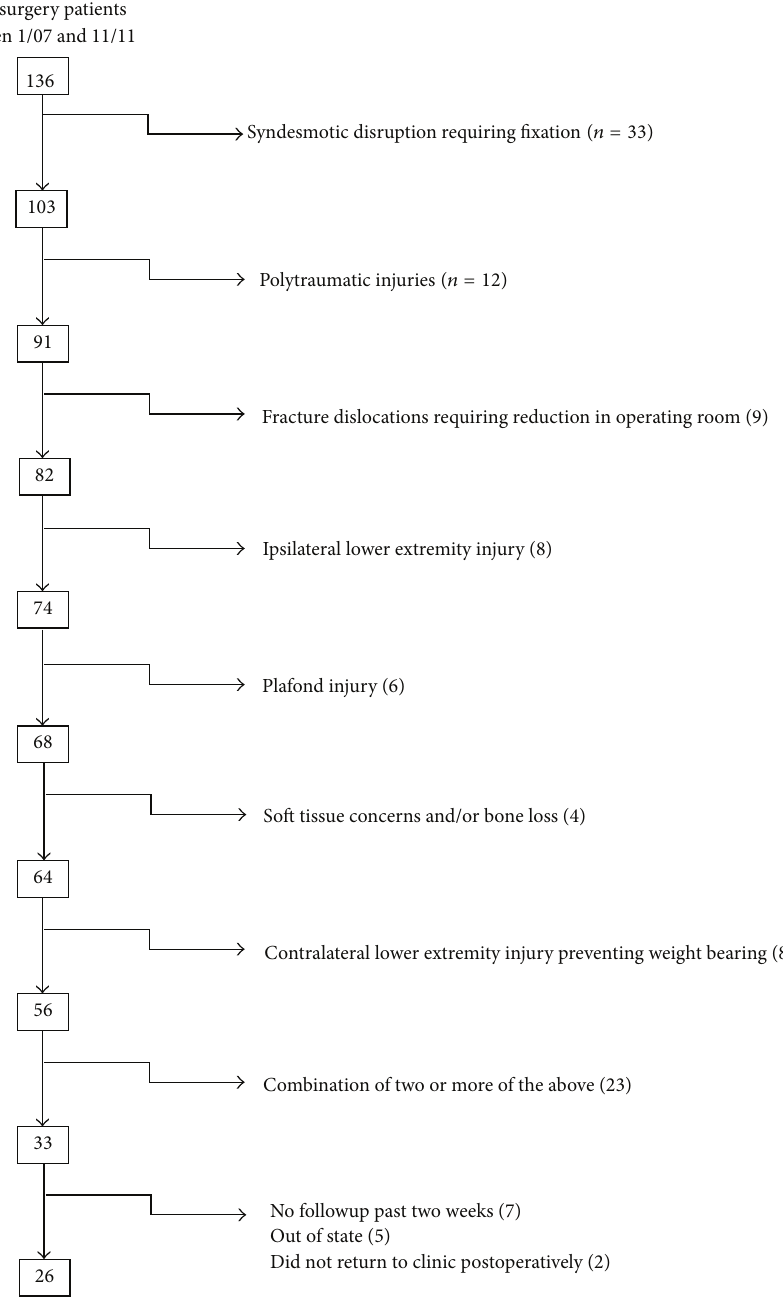
Figure 1: Exclusion diagram for 136 patients with ankle fractures over 23-month